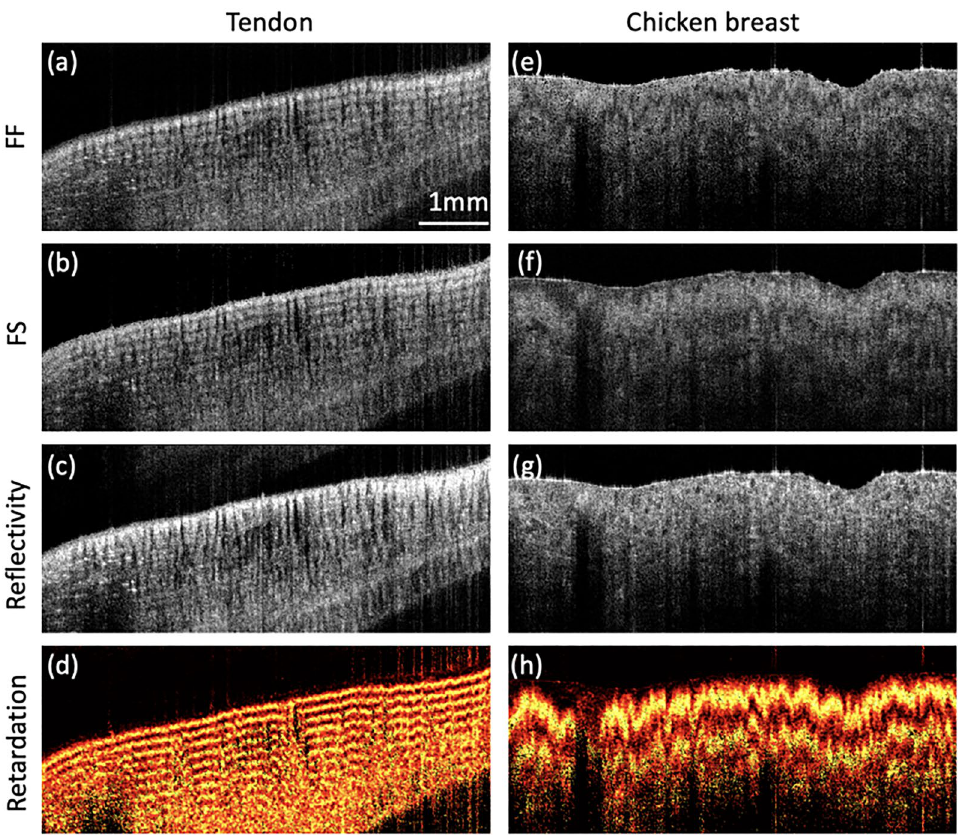
Figure 1. Images of chicken tendon and chicken breast. ( a ) FF image, ( b ) FS image, ( c ) the normal image of reflectivity, and ( d ) the map of sample-field retardation of chicken tendon. ( e ) FF image, ( f ) FS image, ( g ) the normal image of reflectivity, and ( h ) the map of sample-field retardation of chicken breast. Scale bar: 1 mm. The figure is generated by using Matlab R2021a (Version: 9.10.0.1602886, https:// www. mathw orks. com/ produ cts/ new_ produ cts/ relea se202 1a.